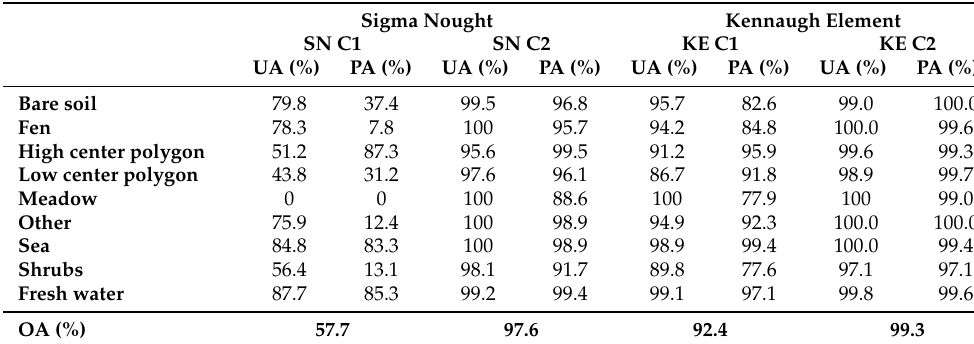
Table 7. The User Accuracy (UA) and the Producer Accuracy (PA) for each land cover class and classification scheme (Table 4).